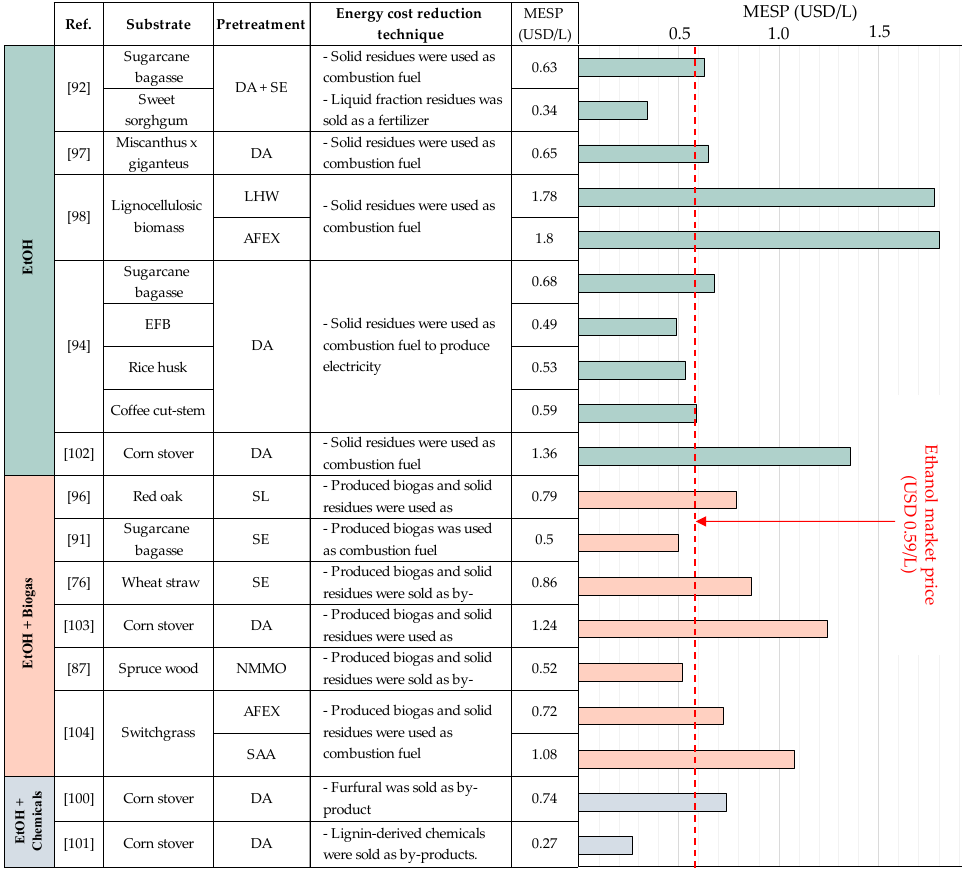
Figure 3. MESPs from various methods employed for the production of bioethanol from 2G biomass. Previous research has demonstrated that in order for the MESP of ethanol produced from lignocellulosic material to compete with that of conventional ethanol, additional utilization of the production process residue is required. This includes direct incineration of the residue as a solid fuel, which provides additional heat for the process, as well as the production of secondary high-value products. However, despite the utilization of residue from the process, the MESP of 2G bioethanol remains significantly higher than the ethanol market price in many studies [98,102–104]. This indicates the need for additional research into the production of ethanol from lignocellulosic biomass in order to increase production efficiency. Additionally, complementary policies such as carbon taxes and incentives may be implemented [105].